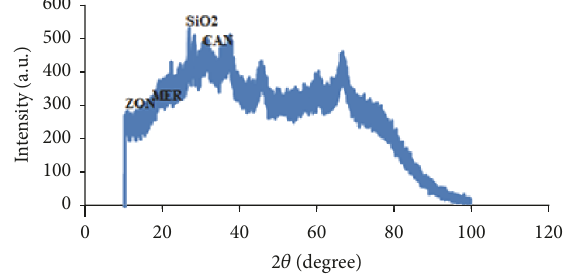
Figure 2: XRD pattern for metakaolin